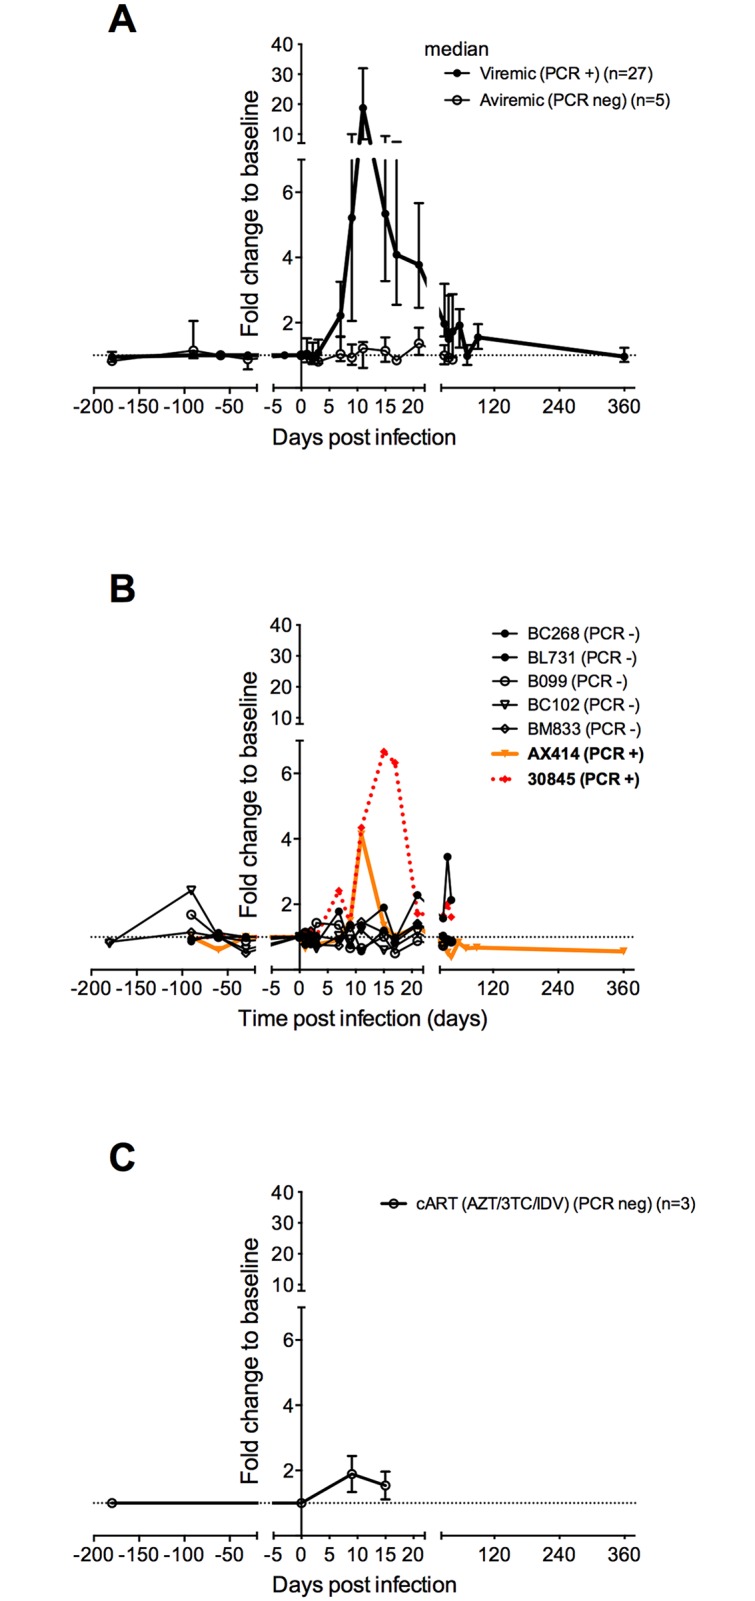
Dynamics of IP-10 levels in viremic and aviremic animals.IP-10 levels in plasma were determined in a longitudinal study, before infection and after SIVmac251 challenge in cynomolgus macaques. Values are expressed as the fold change from baseline (median of 3 to 4 values obtained before infection). A. IP-10 dynamics in 27 viremic and 5 SIV-exposed aviremic animals are shown (median and interquartile range). The latter had no detectable SIVmac DNA in lymph nodes. B. Blood IP-10 dynamics in 2 aviremic animals with detectable cell-associated DNA in lymphoid tissues. Animals AX414 and 30845 were inoculated intrarectally with 5 and 50 AID50 of SIVmac251, respectively. PCR+ = detectable lymph node cell-associated SIVmac DNA on day 14 p.i., PCR neg = undetectable lymph node cell-associated SIVmac DNA.